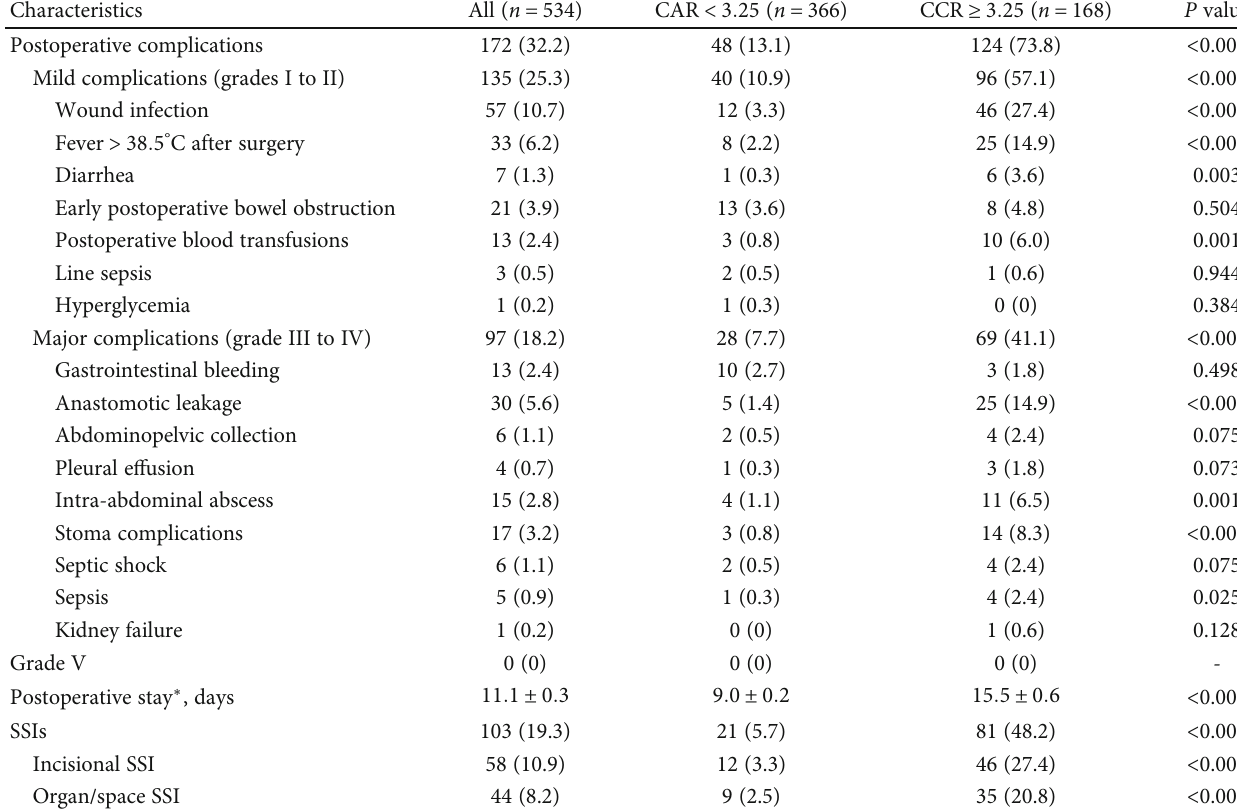
Table 4: Comparison of postoperative complications for bowel resection in CD patients according to postoperative CAR. Characteristics